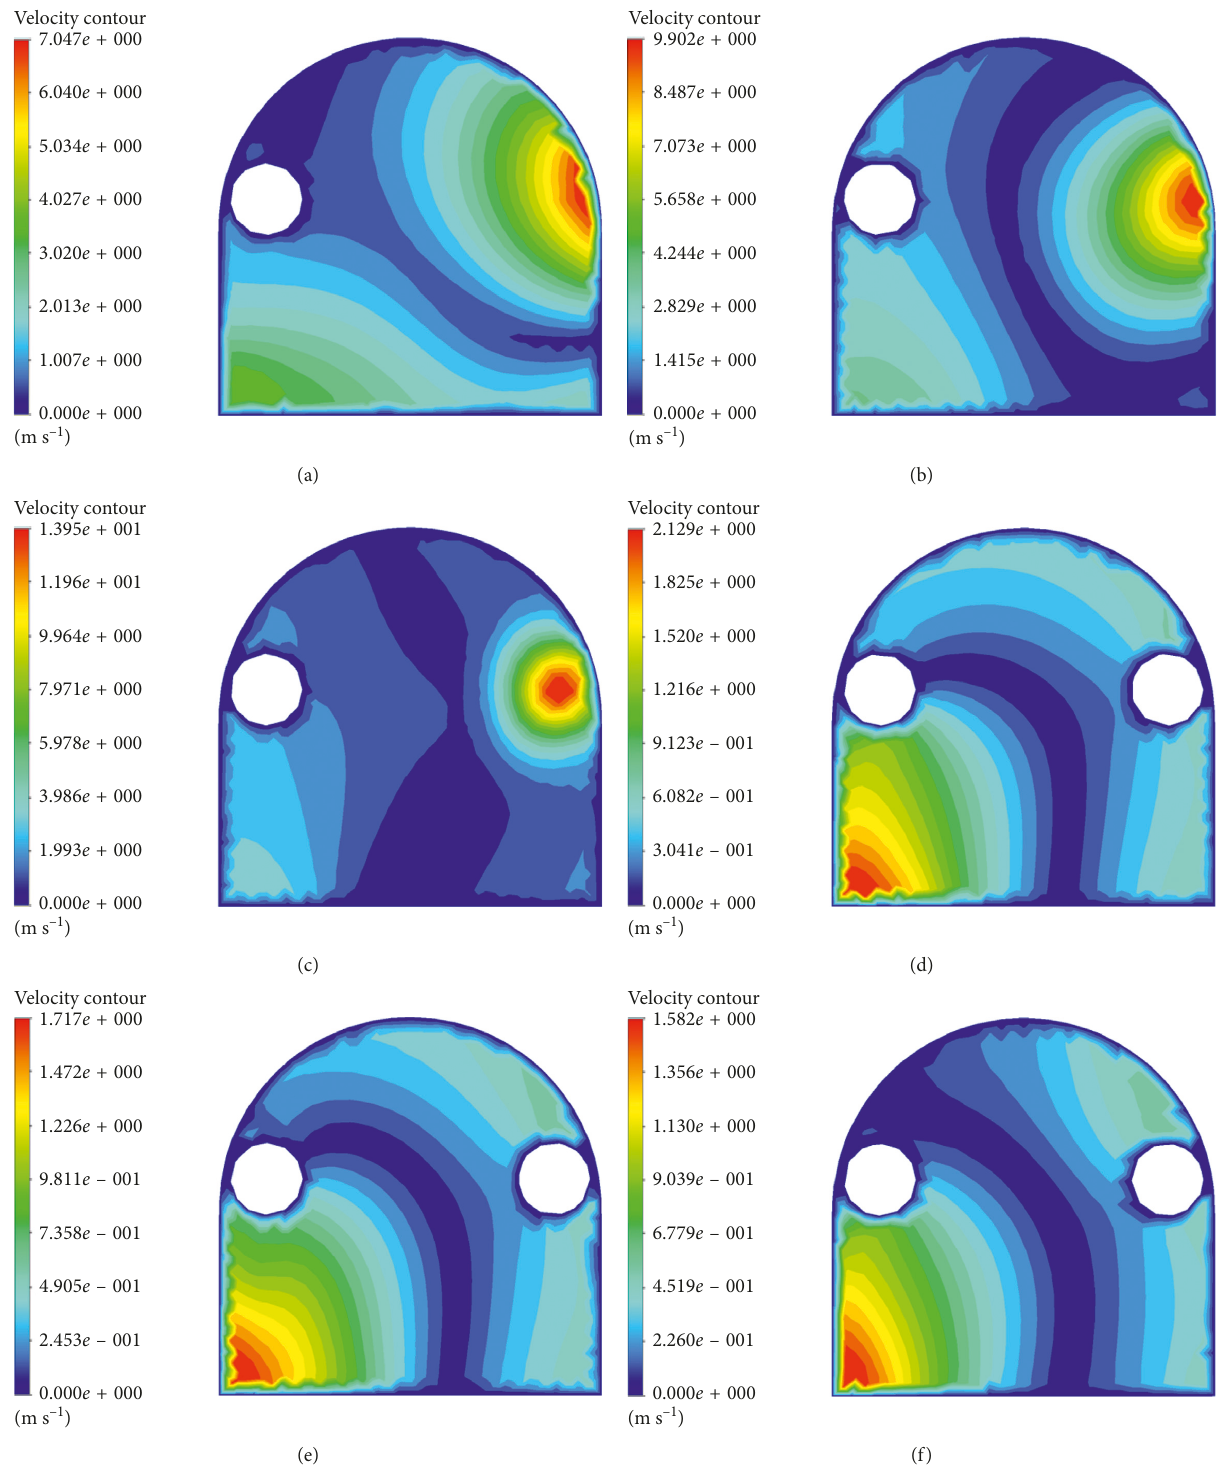
Figure 6: Contour of velocity at different regions. (a) 5 m, (b) 10m, (c) 15m, (d) 25m, (e) 30m, and (f)